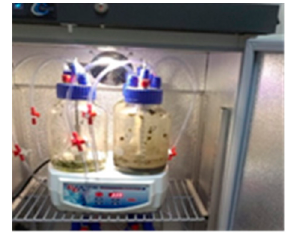
Figure 2. Test stand—the BMP test.